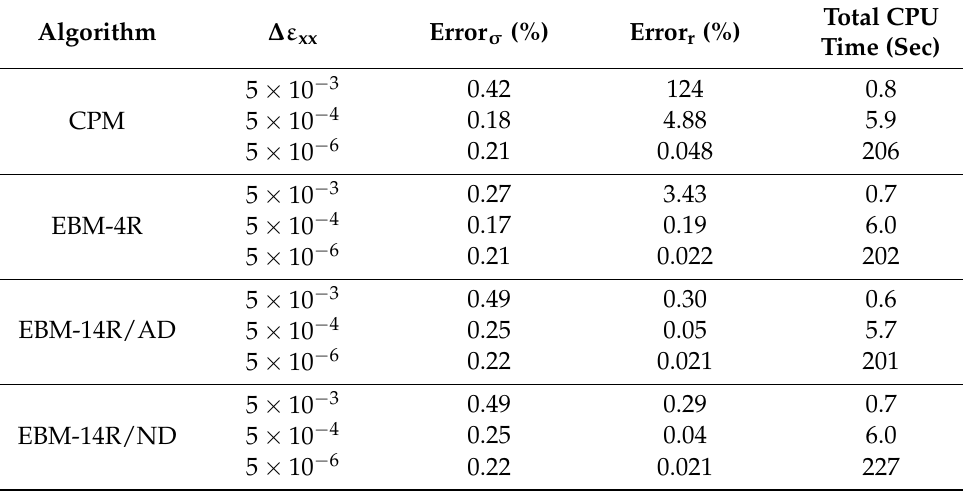
Table 4. Average relative errors in the flow curves and r-values of MAT 2 under